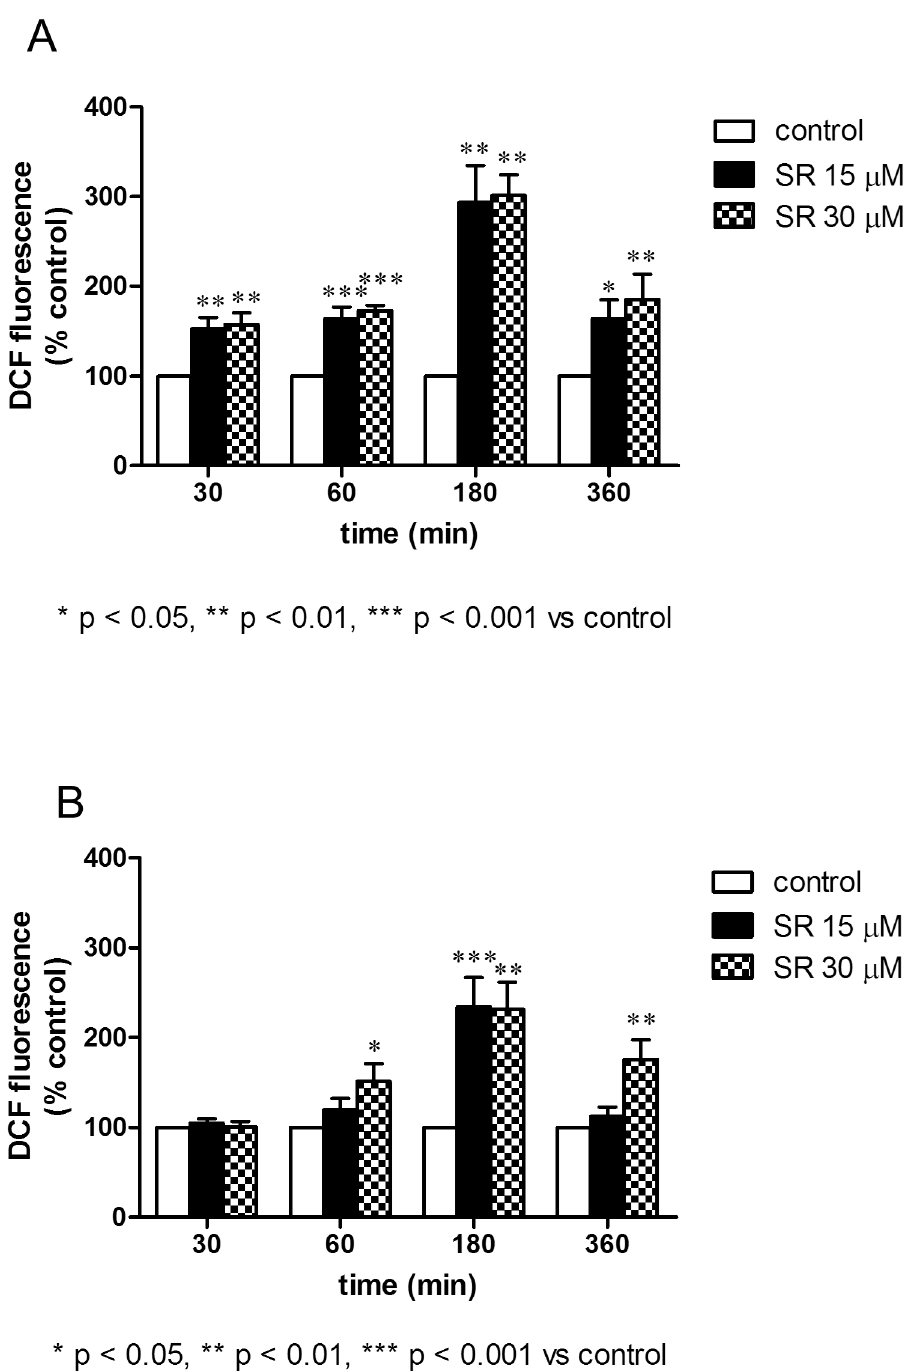
Figure 6. Effect of SR on ROS levels determined in normoxic (A) and hypoxic (B) conditions on REH cells. Cells were treated for 30– 360 min with SR to analyze the oxidation state of the cell by using DCFH-DA as fluorogenic probe. Results are expressed as DCF (2 9 ,7 9 - dichlorodihydrofluorescein) fluorescence (% of control) and are means 6 SEM of four independent experiments.